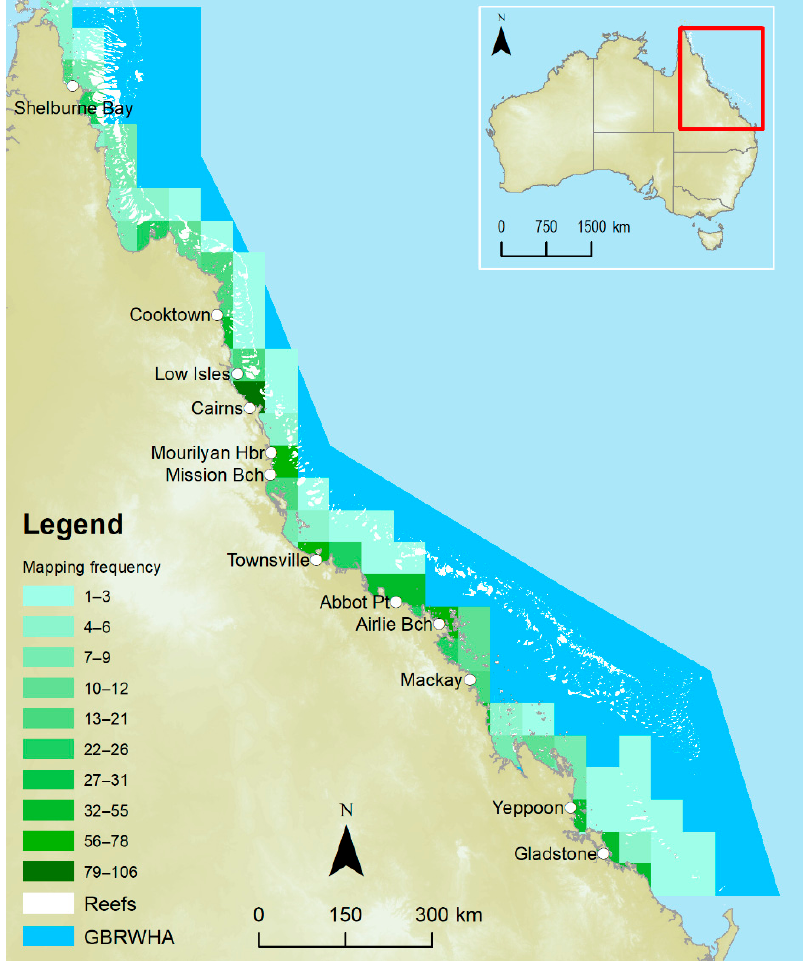
Figure 5. Frequency of seagrass meadow mapping events, within 30 min grids, within the Great Barrier Reef World Heritage Area over the last century